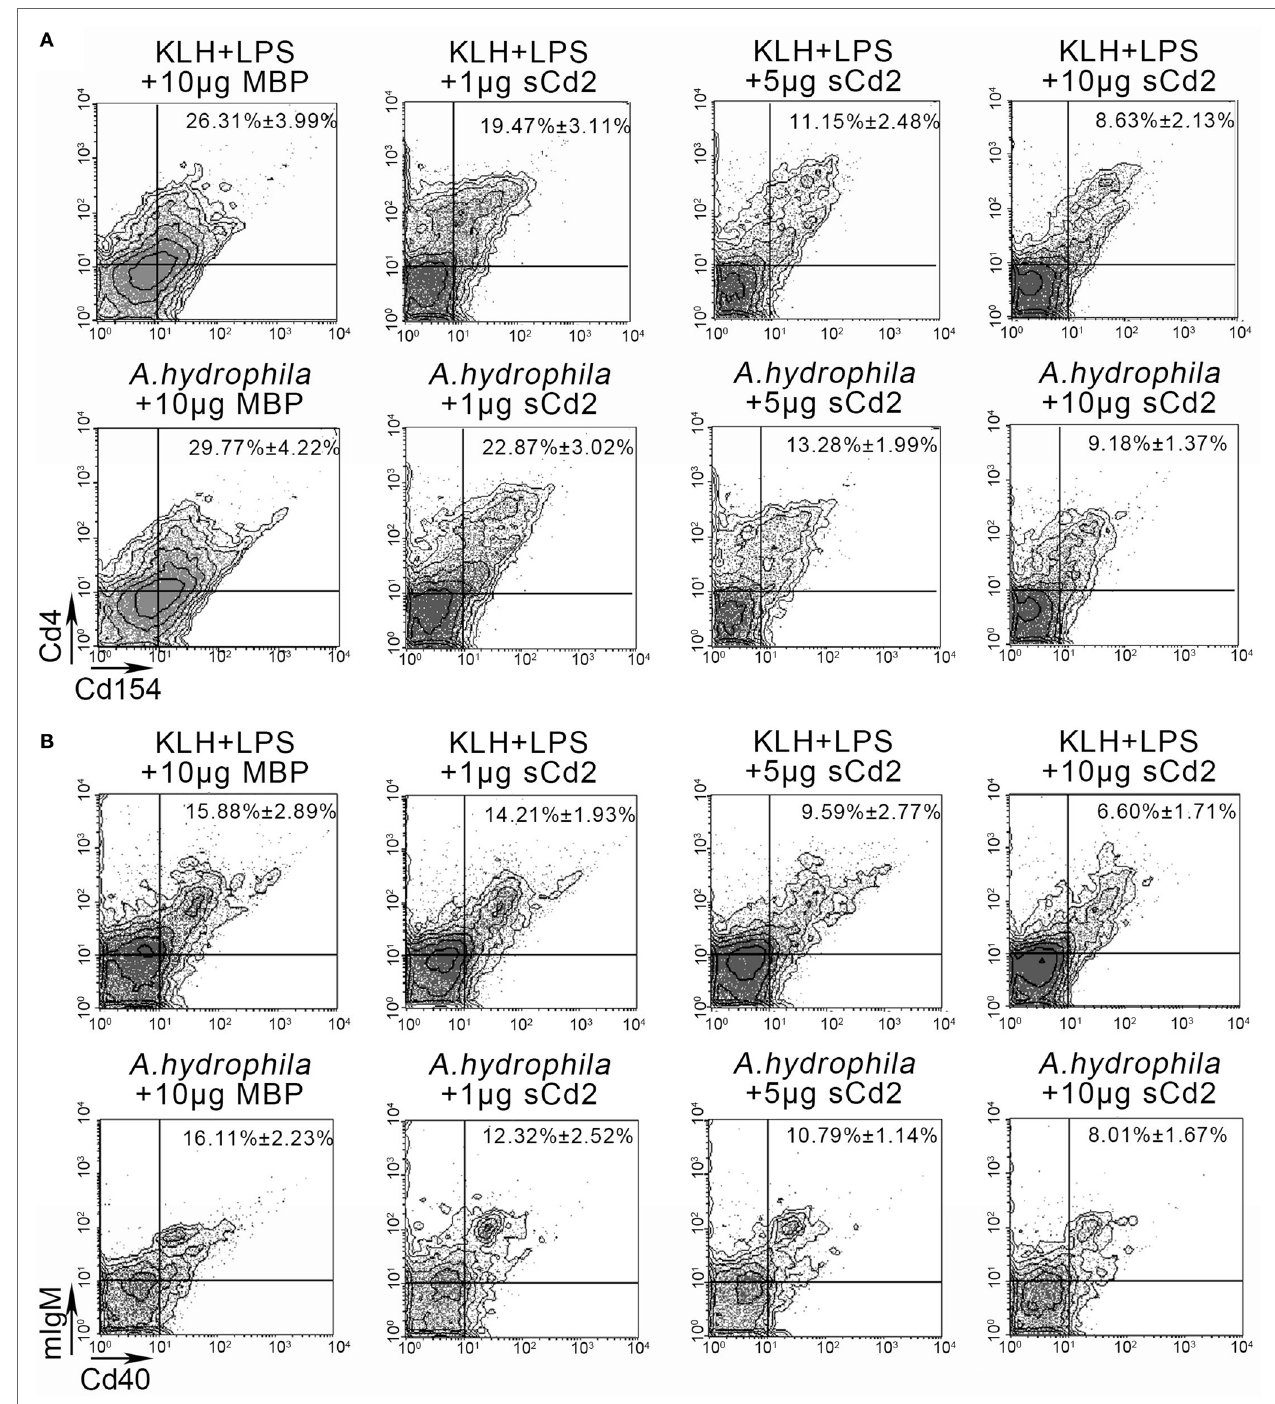
FigUre 10 | Functional evaluation of Cd58 and Cd2 interaction by introducing a recombinant soluble Cd2 protein (sCd2). (a) . The degree of Cd4 + T cell activation was represented by the percentage of Cd4 + Cd154 + cells determined by flow cytometry (FCM). The experimental treatments were presented at the top of each block diagram. The data above the outlined area in each block diagram indicated the average percentage of Cd4 + Cd154 + T cells in each treatment group. (B) The degree of B cell activation was represented by the percentage of mIgM + Cd40 + cells determined by FCM. The experimental treatments were presented at the top of each block diagram. The data above the outlined area in each block diagram indicated the average percentage of mIgM + Cd40 + B cells in each treatment group. Fishes i.p. injected with MBP were used as control. Data points were from three independent experiments ( n =